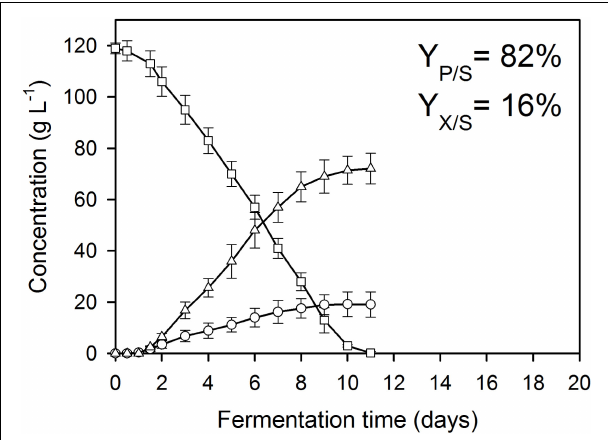
FIGURE 3 | Kinetics of fungal biomass (O), itaconic acid ( (cid:77) ), and residual D -glucose ( (cid:3) ) concentrations in controlled batch fermentations of A. terreus NRRL 1960, grown in a 2-L scale bioreactor in the presence of 300 µ g L − 1 Mn 2 + and 300 mg L − 1 Cu 2 + ions. The variables share the same y -axis as they are expressed in the same unit (g L − 1